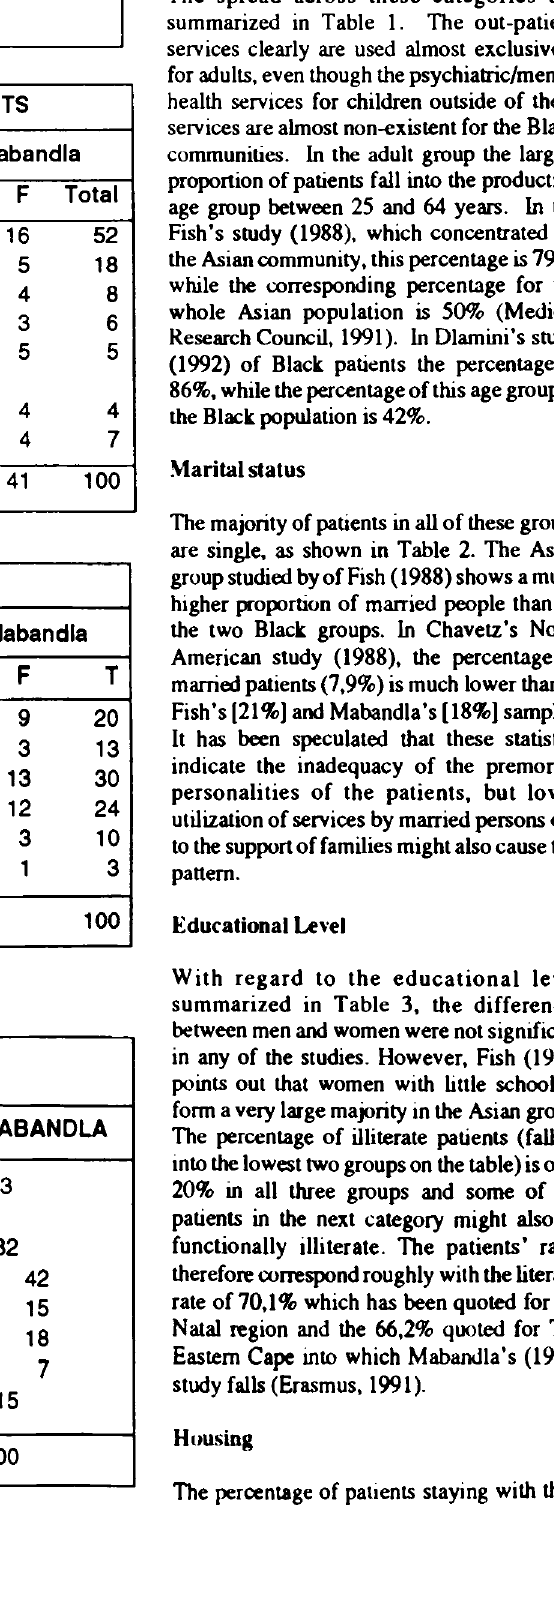
TABLE II. MARITAL STATUS OF PSYCHIATRIC OUTPATIENTS